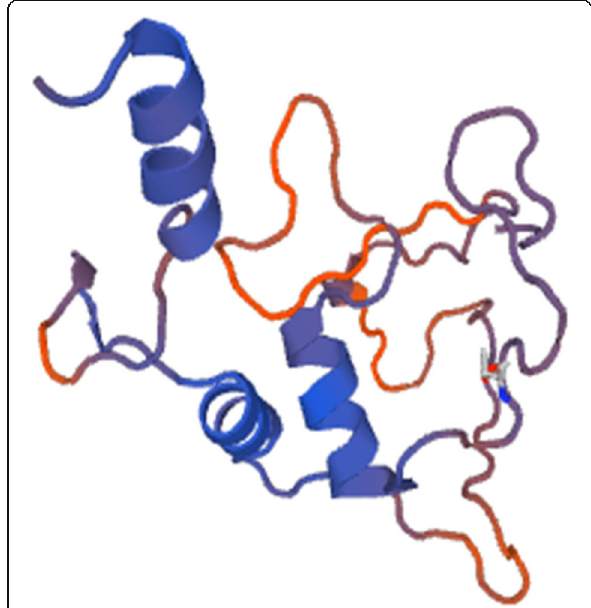
Fig. 14 3D model of purified protease S.AMP13 by using SWISS-MODEL